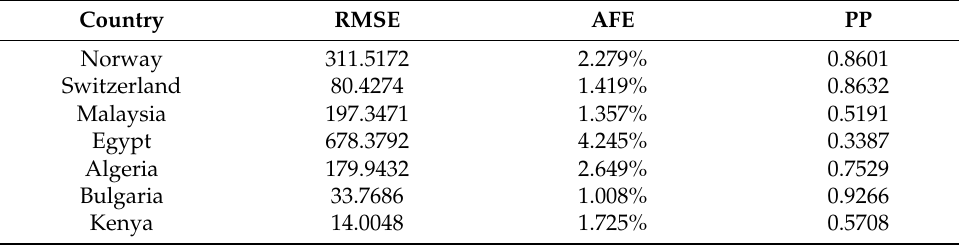
Table 4. Forecasting results for the FTS model.